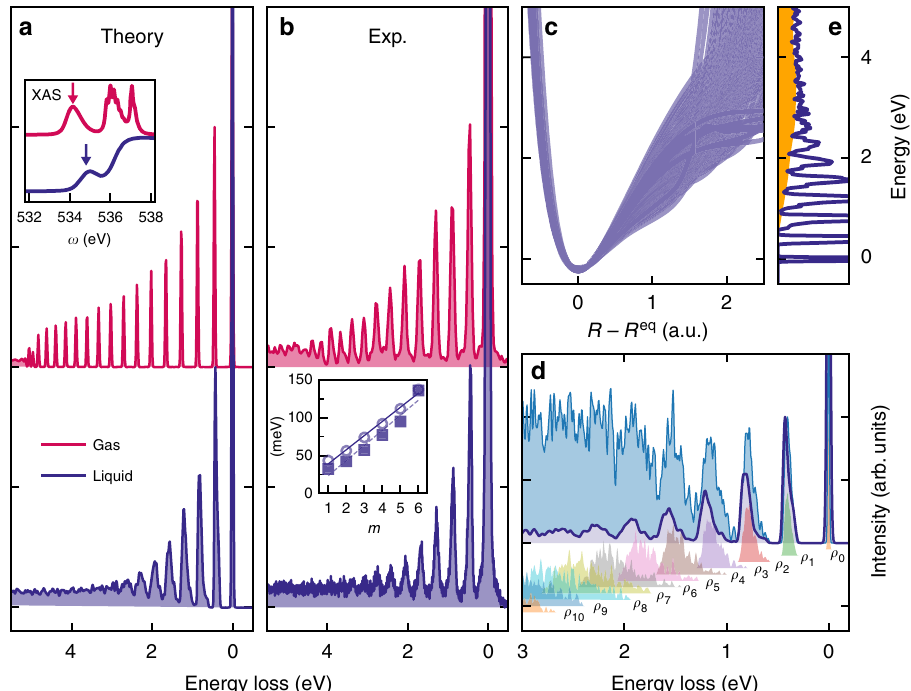
Fig. 1 Resonant inelastic X-ray scattering (RIXS) spectra of water in gas/liquid-phase under 4 a 1 /pre-edge core-excitation. a Theoretical RIXS spectra of gas-phase and liquid water vs. the energy loss ( ω − ω ′ ). The inset shows energy of resonant excitation in the experimental XAS of free water molecules and liquid water (from ref. 15 ). b Experimental RIXS spectra of gas-phase and liquid water. The inset compares experimental (circles) and theoretical (squares) peak widths in meV as a function of the peak number m . c Ab initio potential energy curves along the OH bonds for each of the 64 sampled water molecules in liquid water. d Partial densities of the vibrational states ρ n (see Eq. (7)) and the total density of states ρ ¼ pro fi le σ . e Overlap of the partial RIXS cross-sections results in the formation of a background shown in yellow (compare with the overlap of the partial densities of vibrational states d )